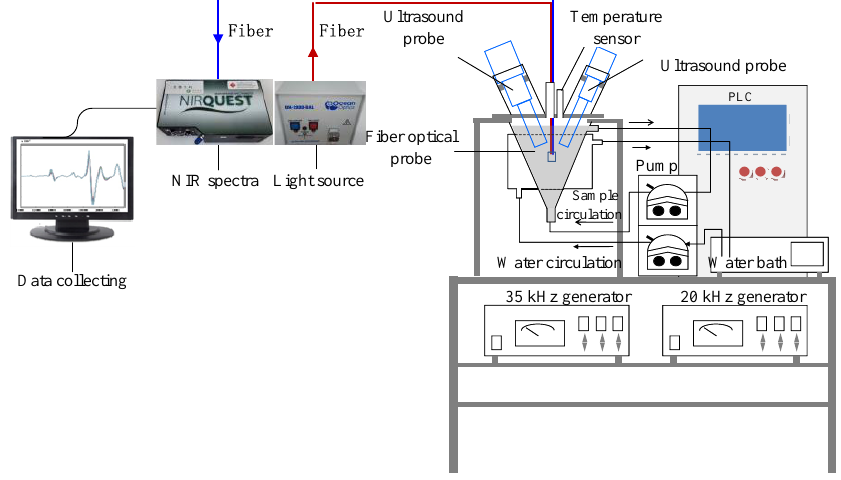
Figure 6. The equipment drawing of in-situ monitoring system in ultrasound treatment process.